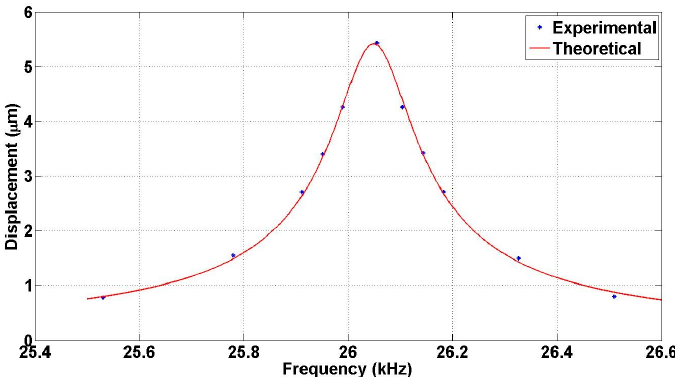
Figure 15. Mirror displacement as a function of the AC signal frequency at applied voltage of 70 V DC and 8.5 V AC for design A.